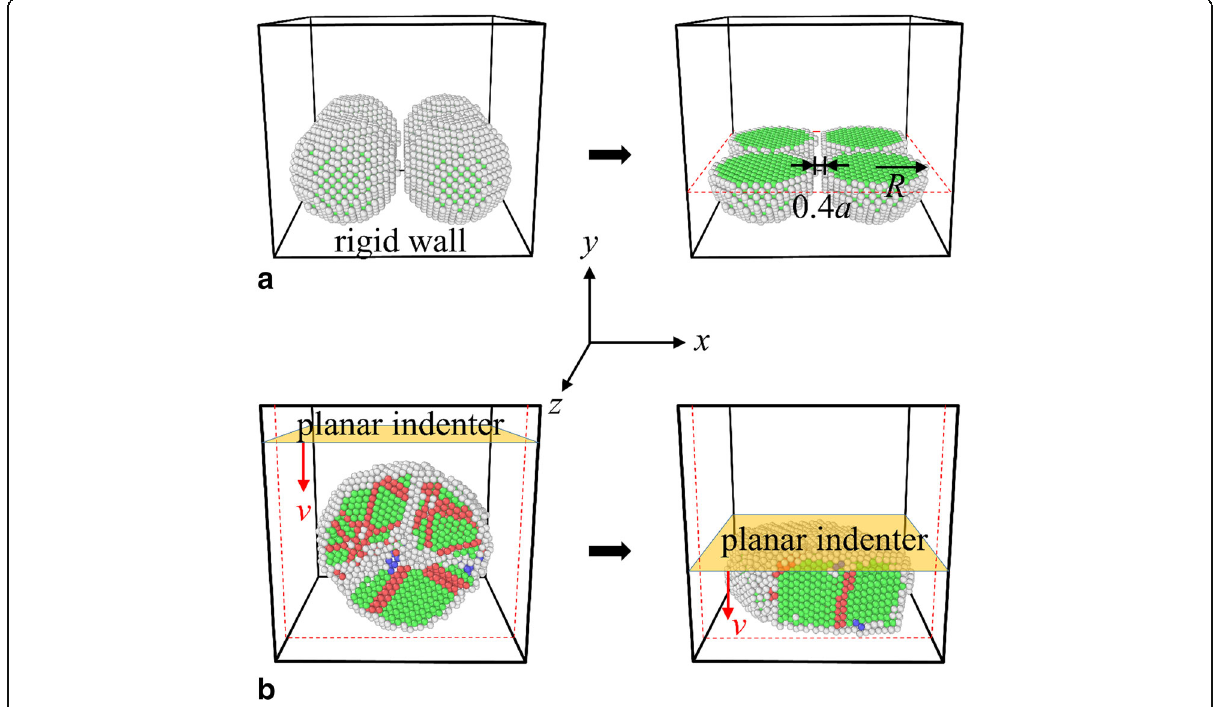
Fig. 1 Schematic plots of the simulated system. a Schematic plots of the initial system and the corresponding sectional view (cut by the plane represented by red dashed lines ), in which the geometrical sizes are denoted. b Schematic plots (sectional view) of the compressed sintered product at different times, in which the planar indenter moves downwards with a constant velocity v . Here, the atoms in green, red , and blue are those in local FCC, hexagonal-close-packing (HCP), and body-centered-cubic (BCC) lattices, respectively, while disordered atoms in gray represent surfaces and dislocation cores. The planes bounded by solid lines represent six rigid